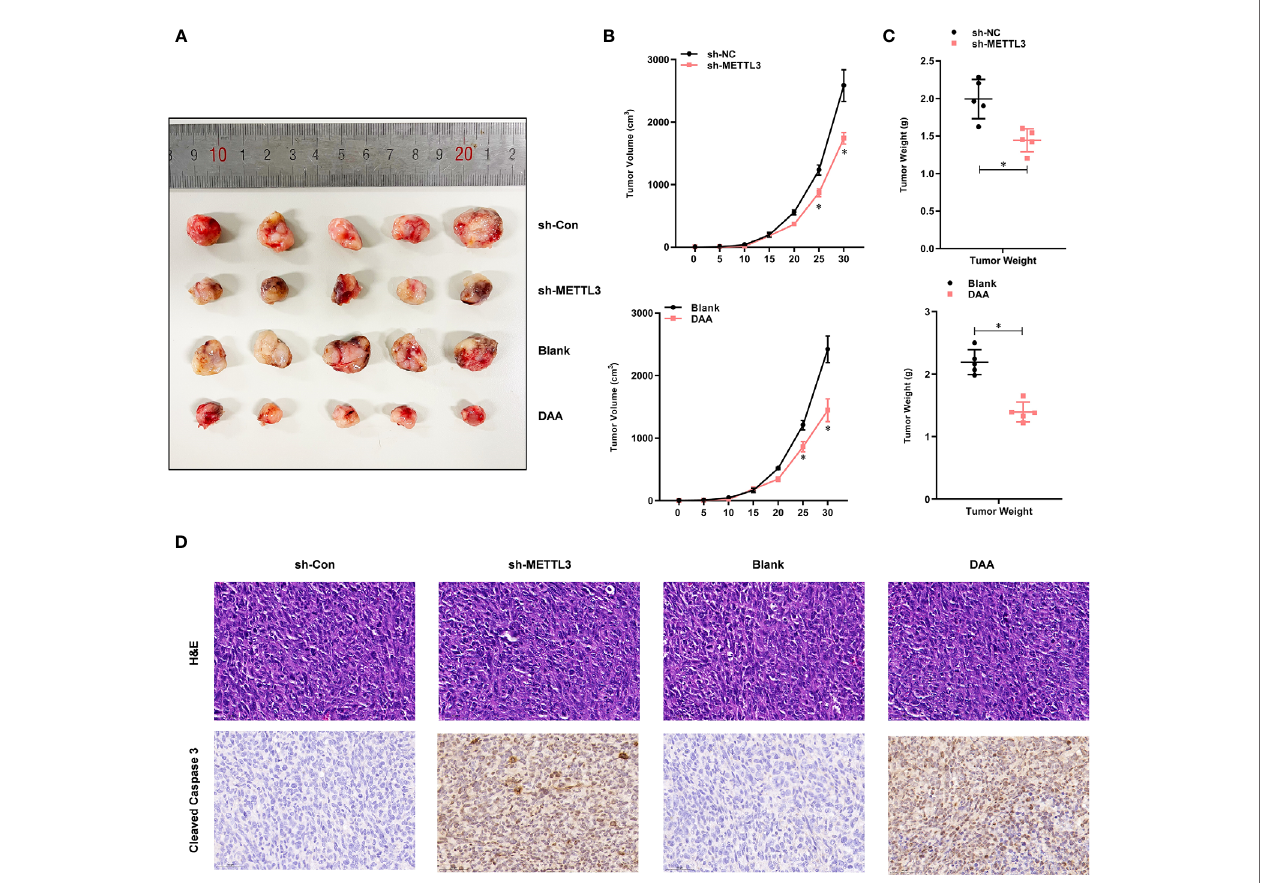
FIGURE 5 | METTL3-mediated m 6 A modi fi cation contributes to the TMZ resistance in vivo . (A) Representative images of four groups of U87-MG-TMZ cells (shNC, shMETTL3, blank, and DAA)-derived subcutaneous tumors in the presence of TMZ. (B) Growth curve of tumor xenografts originated from four groups of U87-MG- TMZ cells (shNC, shMETTL3, blank, and DAA) in the presence of TMZ, (C) Weight of tumor xenografts originated from four groups of U87-MG-TMZ cells (shNC, shMETTL3, blank, and DAA) in the absence of TMZ. (D) IHC analysis of cleaved caspase-3 in tumor xenografts originated from four groups of U87-MG-TMZ cells (shNC, shMETTL3, blank, and DAA) in the presence of TMZ. * P < 0.05 versus indicated control U87-MG/U251